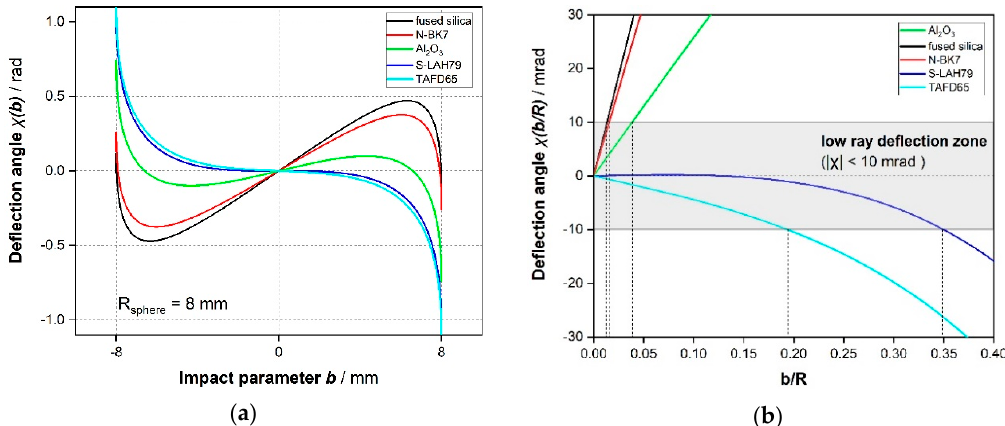
Figure 7. ( a ) Deflection angles plot for five types of glass, depending on their impact parameter ( R = 8 mm is fixed for all the spheres). ( b ) Highlight on low ray deflection zone for the same glasses, depending on the normalized impact parameter.